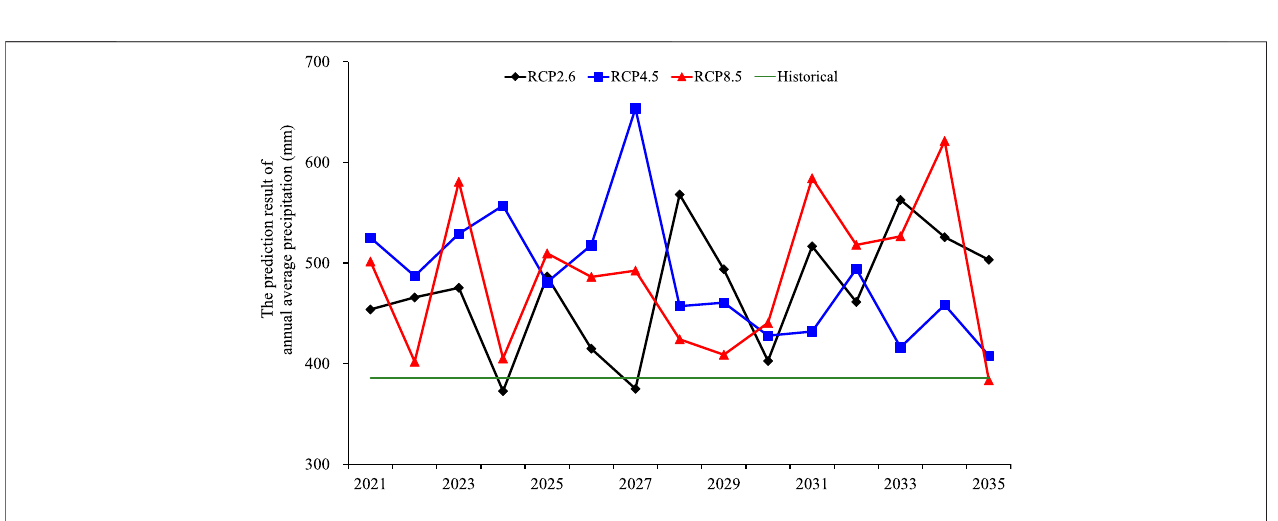
FIGURE 7 | The annual average precipitation prediction results of the Xining station.